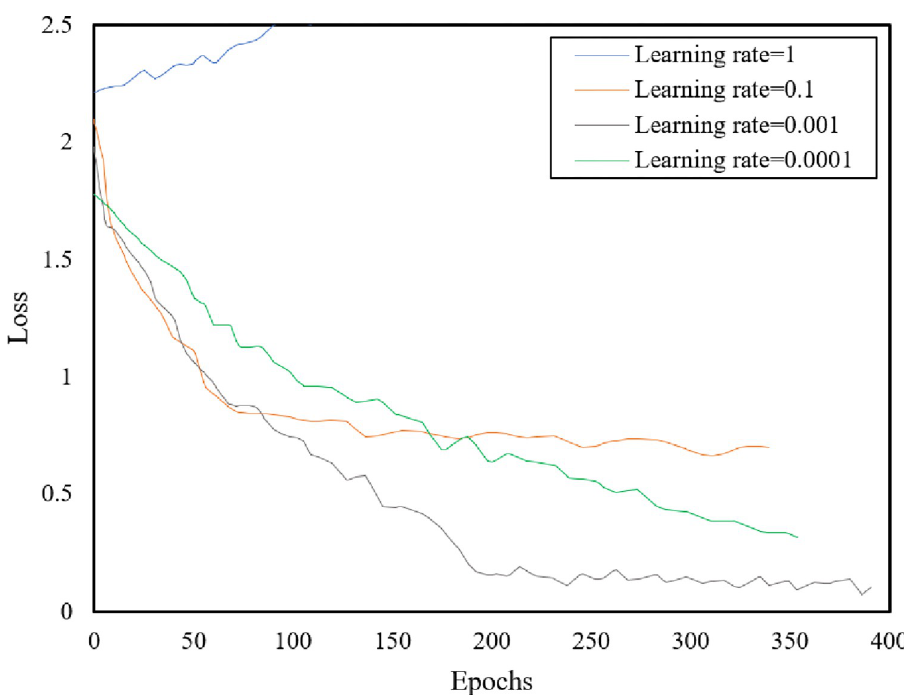
Fig 8. Curves of training loss with different learning